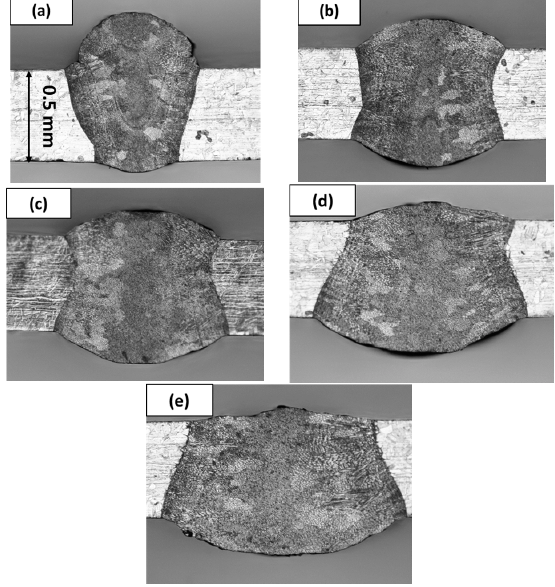
Figure 4. Cross ‐ sections of weld bead under different pulse duration: ( a ) τ = 4 ms; ( b ) τ = 5 ms; ( c ) τ = 6 ms; ( d ) τ = 7 ms; ( e ) τ = 8 ms.